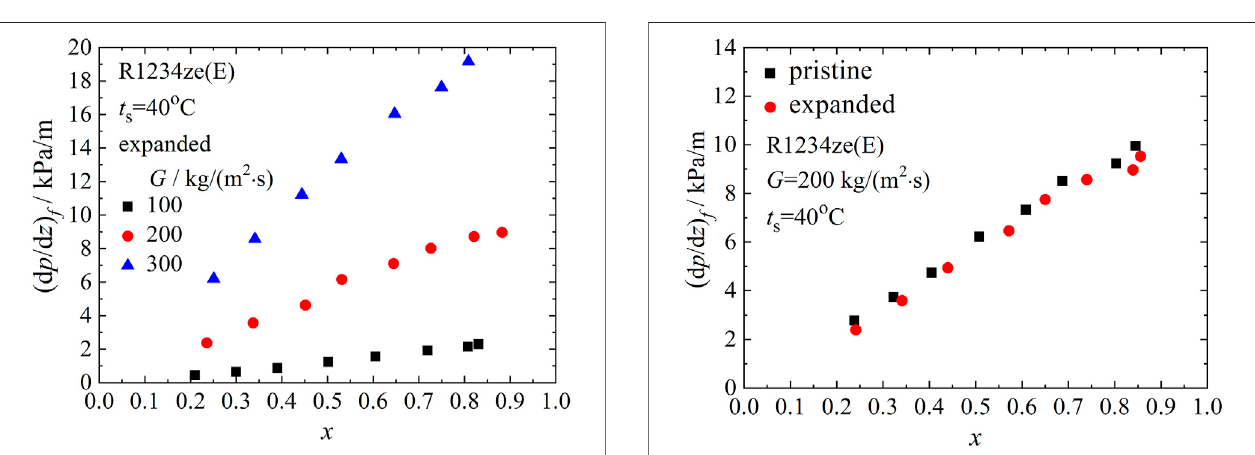
FIGURE 8 | Friction pressure gradients in the expanded micro- fi n tube.